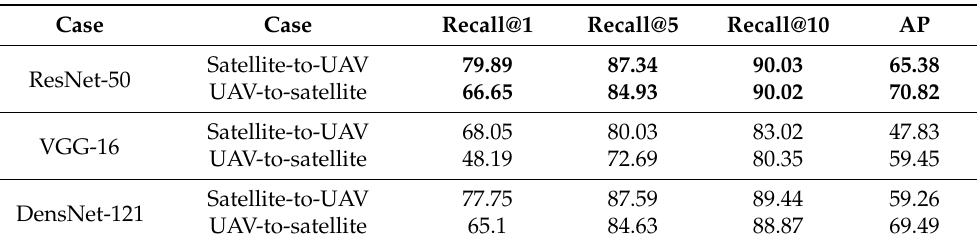
Table 3. Comparison of matching accuracy of three different backbone networks after being used in LCM (a single image is used as the query).